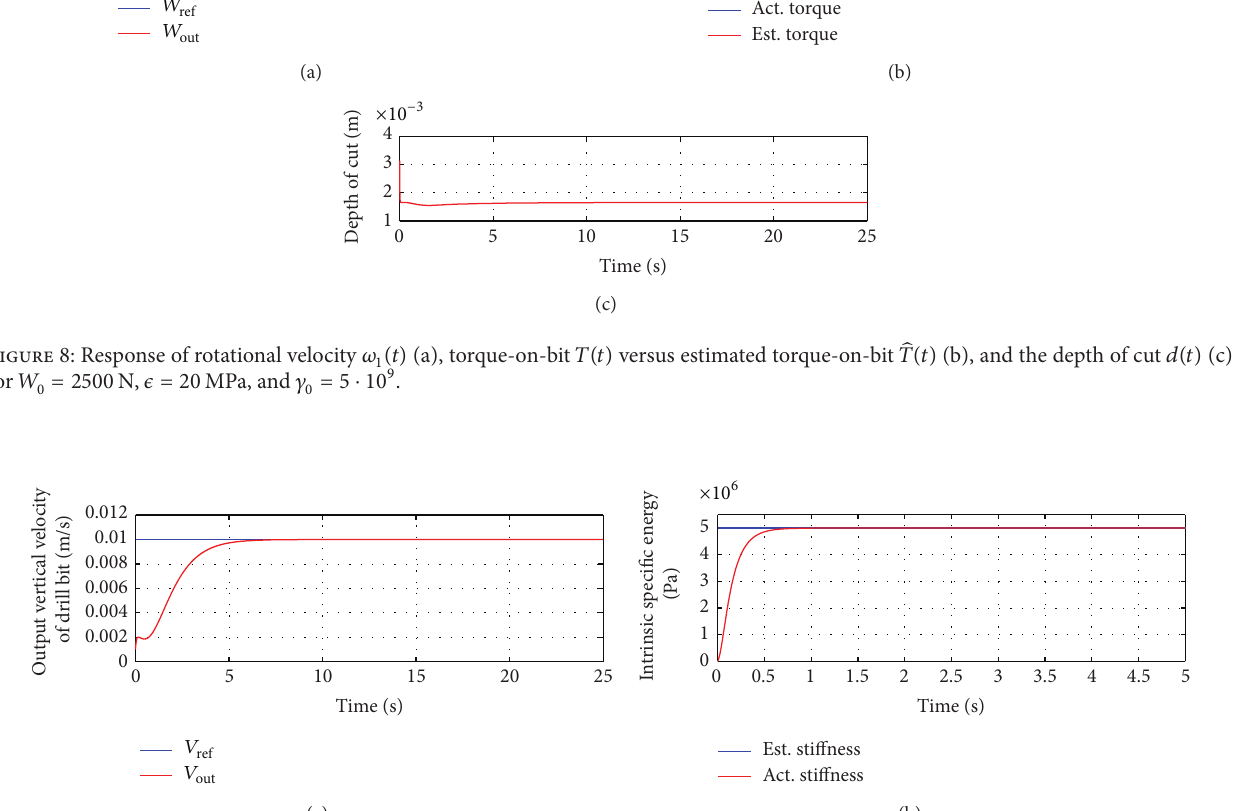
Figure 9: Response of the vertical velocity V (𝑡) (a) and the intrinsic specific energy estimate ̂𝜖(𝑡) (b) for 𝑊 0 = 2500 N, 𝜖 = 5 MPa, and = 5 ⋅ 10 9 𝛾 0